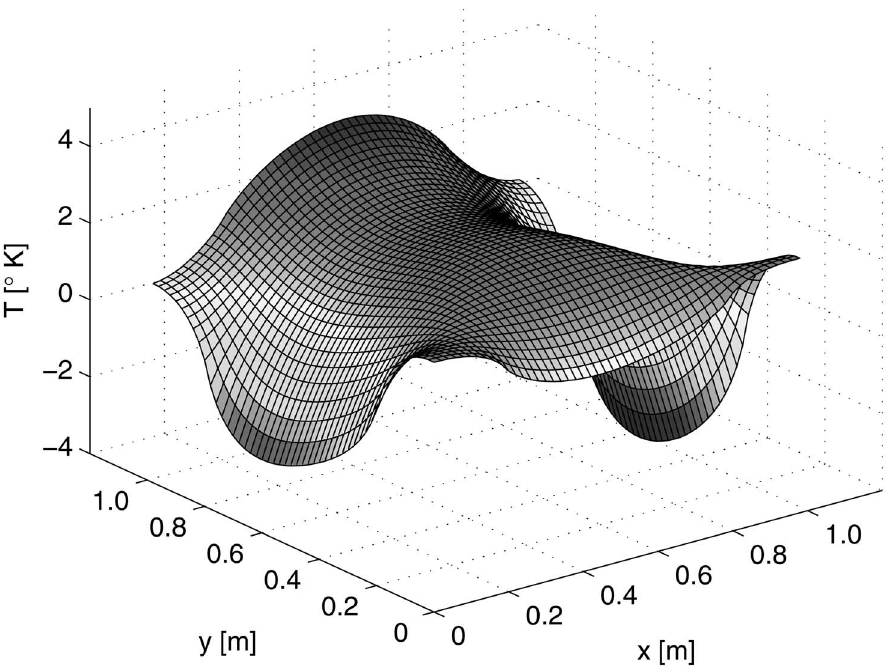
Figure 3. Steady-state error, after 20 minutes.